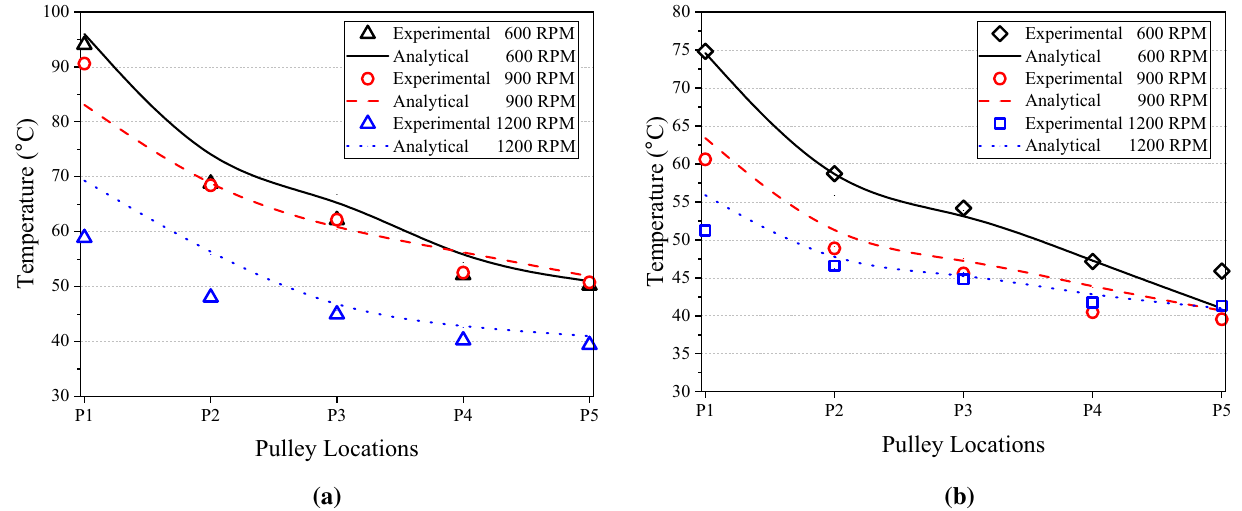
Figure 15. Comparison of experimental and analytical temperature distributions at P1–P5 under the CS condition for ( a ) DR pulley and ( b ) DN pulley. Pulley ID Conditions